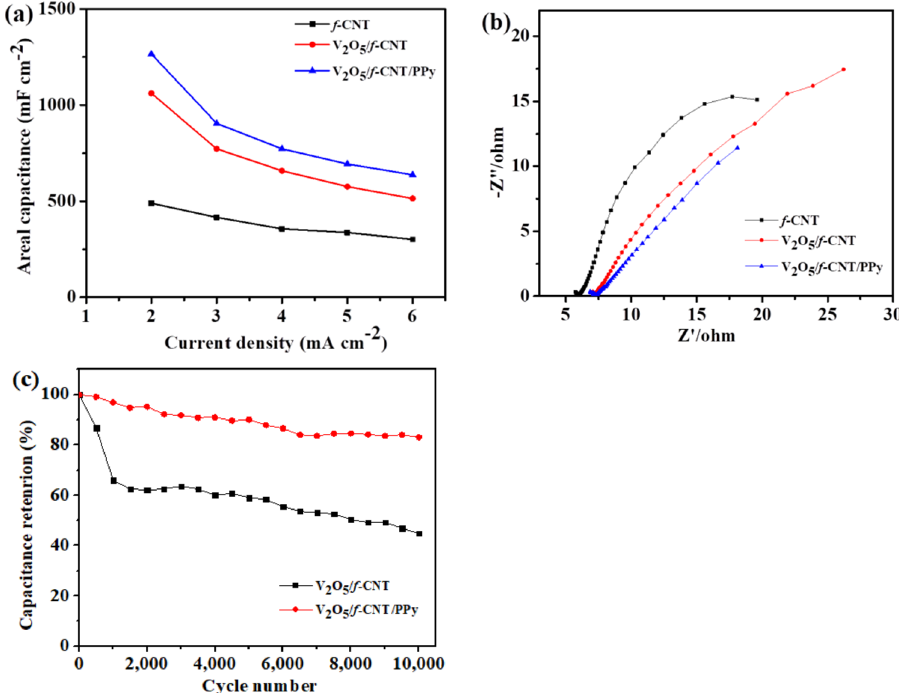
Figure 10. ( a ) EIS spectra, ( b ) areal capacitances vs. current density plot, and ( c ) cycle life test of V 2 O 5 / f -CNT and V 2 O 5 / f -CNT/PPy electrodes.